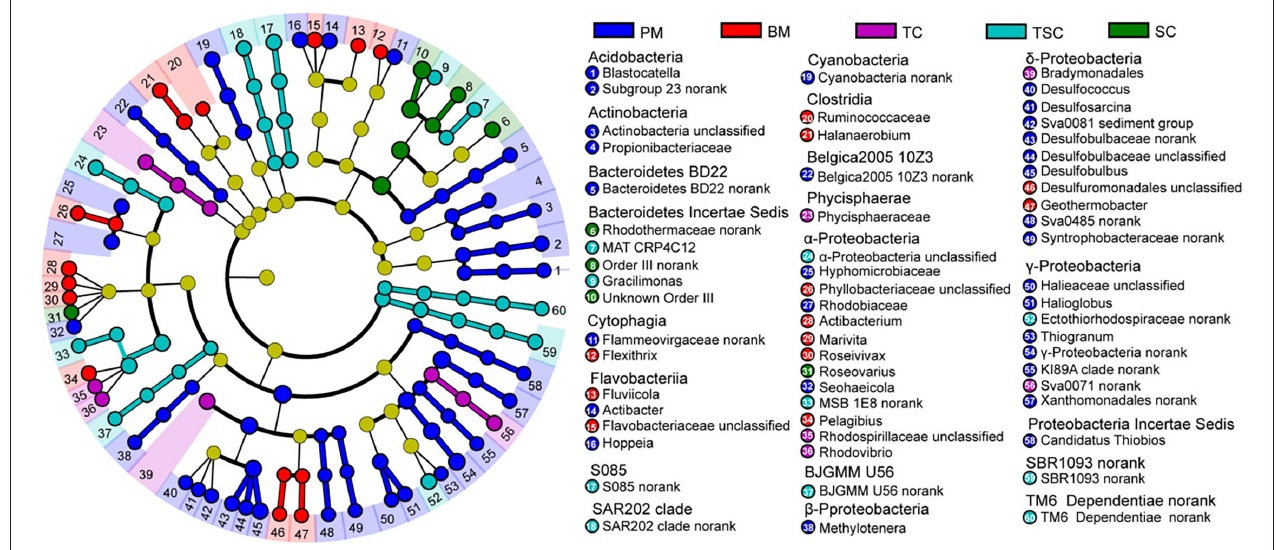
FIGURE 5 | Linear discriminant analysis effect size (LefSe) of bacterial biomarkers in the five